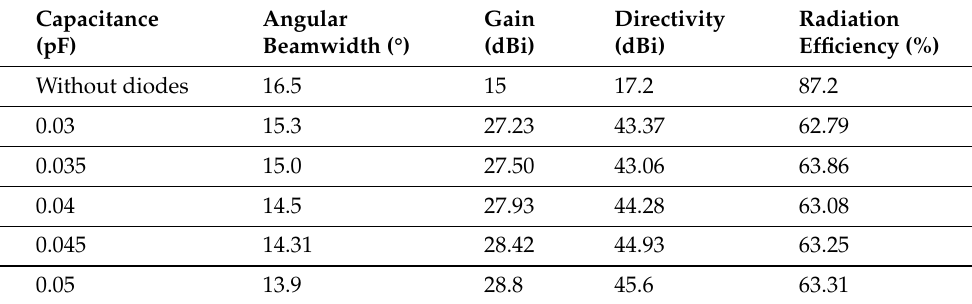
Table 4. Summary of the gain, directivity, and radiation efficiency. Capacitance